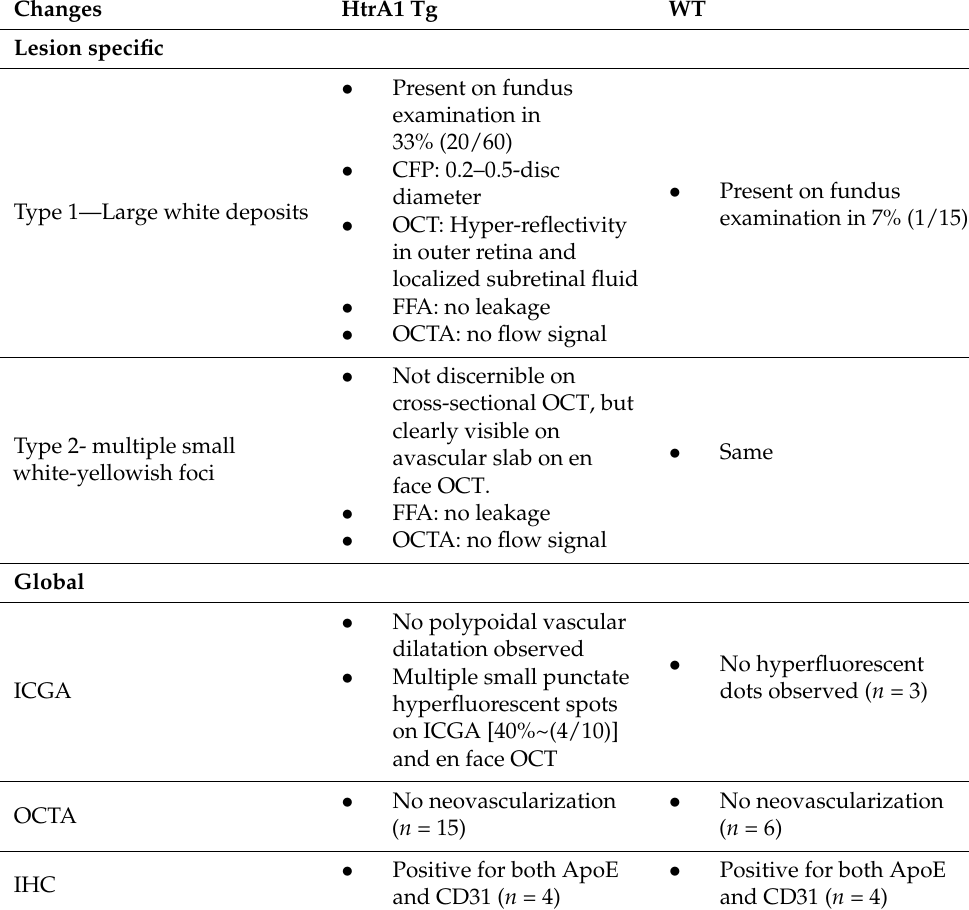
Figure 1. In vivo retinal imaging using combined color photography and OCT retinal imaging com- pared between CAG-HtrA1 Tg mice and wild-type (20 months). ( A ) CFP from the CAG-HtrA1 Tg mice shows the area of large white lesion accumulation ( B ) Yellow-whitish foci scattered through the retina in the CAG-HtrA1 Tg mice. ( C , F ) CFP and cross-sectional OCT scan from the wild type mice. ( D , G ) Cross-sectional OCT scans show the RPE elevation on OCT corresponding to the large white lesions, indicating the small amount of subretinal fluid. ( E , H ) Cross-sectional OCT showing diffuse irregular reflectivity of the RPE layer and ellipsoid zones ( E ) and some intraretinal hyper- reflective foci ( H ) in the eyes with yellow-whitish foci ( I , J ) No leakage, oozing, or staining from neither of the mice groups noted from the FFA images corresponding the lesion from the fundus.